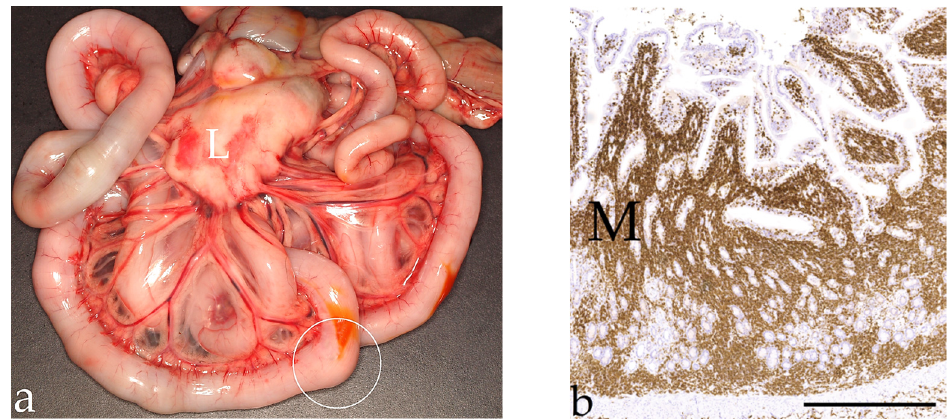
Figure 3. Alimentary lymphoma. ( a ): Macroscopy of a markedly enlarged lymph node (L) and a nodular mass (circle) in the small intestine of a 13-year-old male domestic short-haired cat. ( b ): Immunohistochemistry of a T-cell lymphoma (small cell) with intense CD3 expression of neoplastic lymphocytes visible in the mucosa (M) of a 12-year-old male castrated DSH; (IHC, bar = 600 µm). Microscopically, the gastric and/or intestinal mucosa ( n = 49), mucosa and lamina propria ( n = 24) and mucosa, lamina propria, tunica muscularis and serosa ( n = 606)